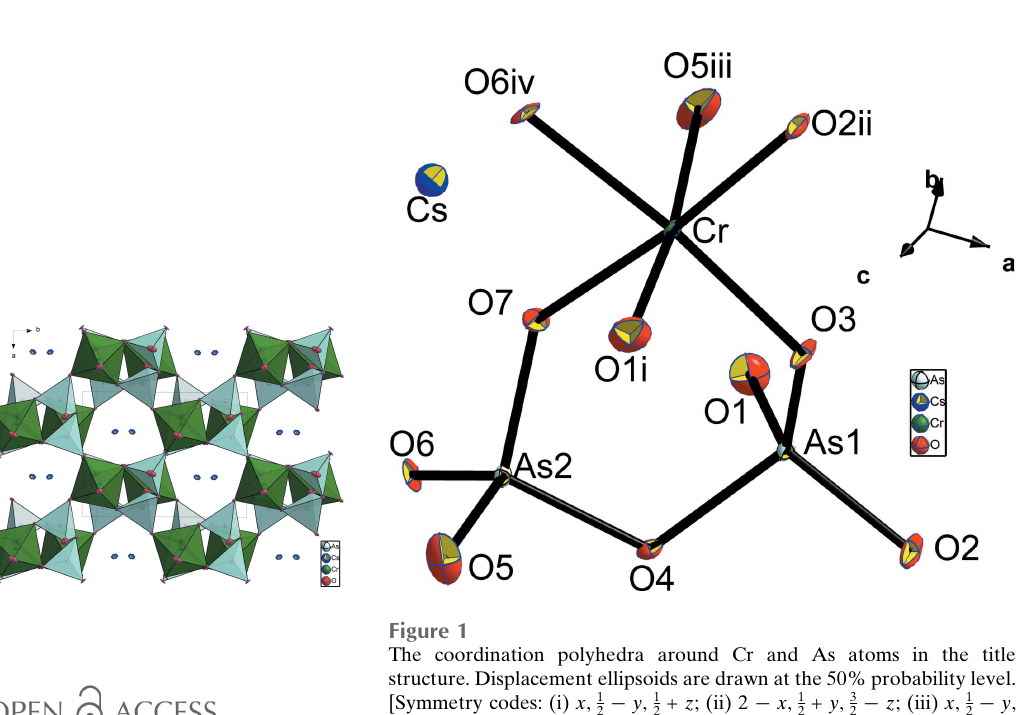
(cid:2) z ; (iii) x , 1 (cid:2) y , + y , 3 2 2 2